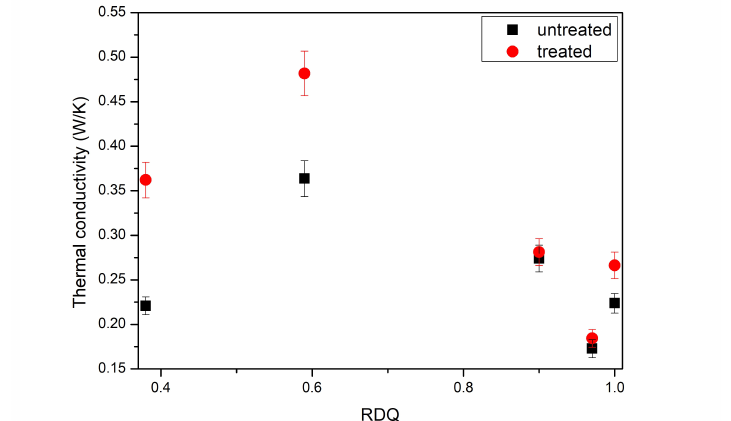
Figure 3. Thermal through-plane conductivity of untreated and post treated samples with different relative dispersion